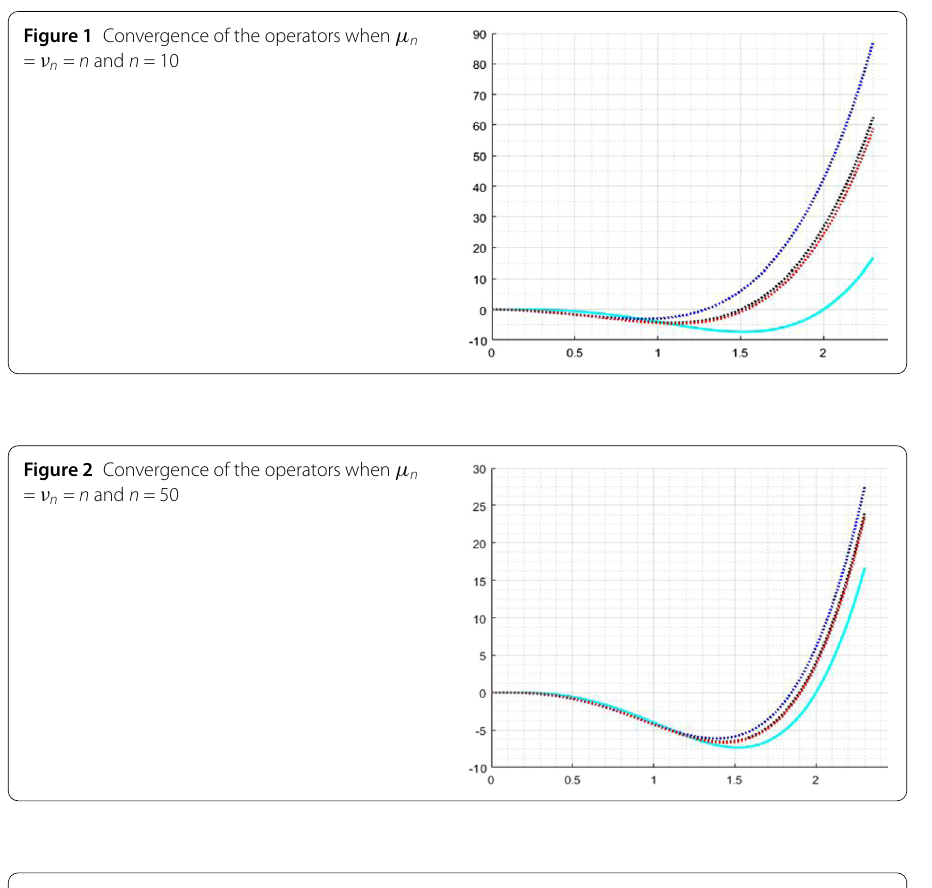
Figure 3 Convergence of the operators when μ n = ν n = n and n = 100